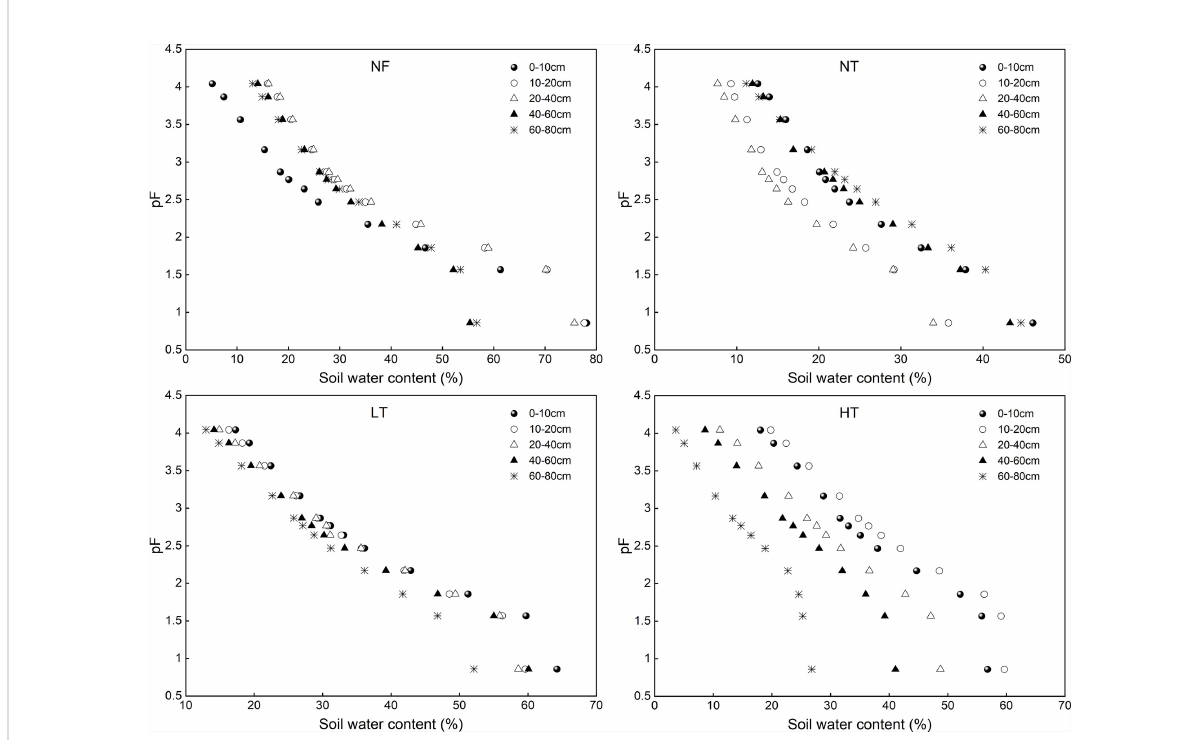
FIGURE 2 Soil water characteristic curves for different soil layers under different management practices of P. crassifolia .